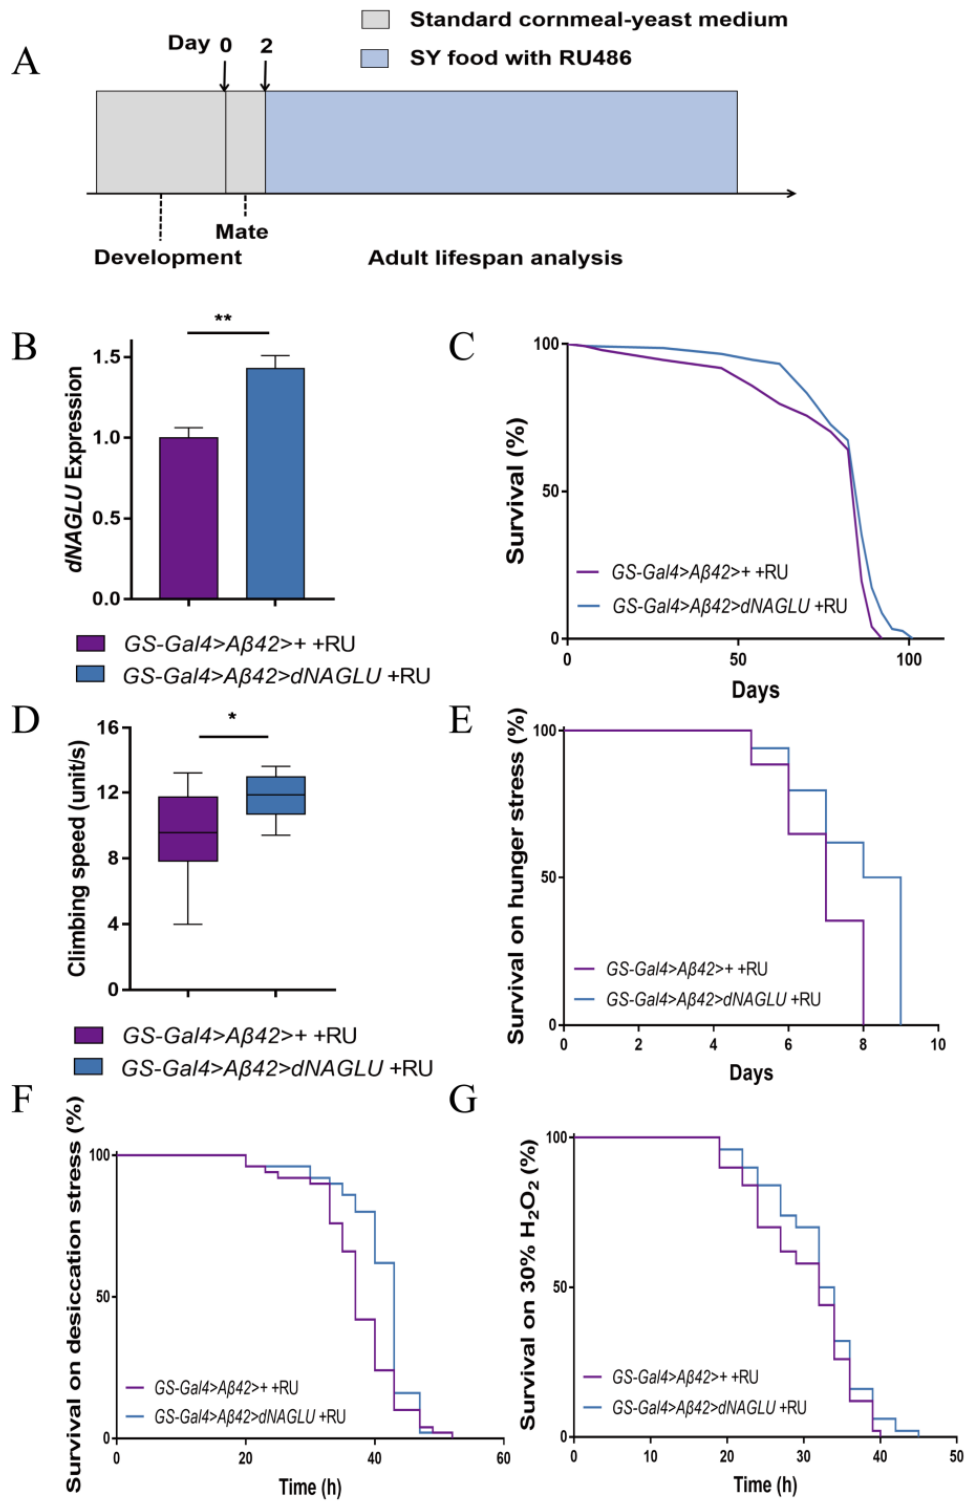
Figure 3. Effects of dNAGLU overexpression on the lifespan in Drosophila AD models: ( A ) Experimental timeline for feeding adult flies to experimental diets; ( B ) qRT-PCR validation for expression of dNAGLU in AD flies (** p < 0.01, t -test); ( C ) survival curves of Drosophila overexpressing dNAGLU in AD flies ( p = 0.0004, log-rank test); ( D , E ) effects of dNAGLU overexpression on stress tolerance in AD flies; ( D ) climbing assay, (* p < 0.05, t -test); ( E ) hunger stress assay, ( p < 0.0001, log-rank test); ( F ) desiccation stress assay, ( p = 0.0018, log-rank test); ( G ) H 2 O 2 stress assay, ( p = 0.1850, log-rank test).